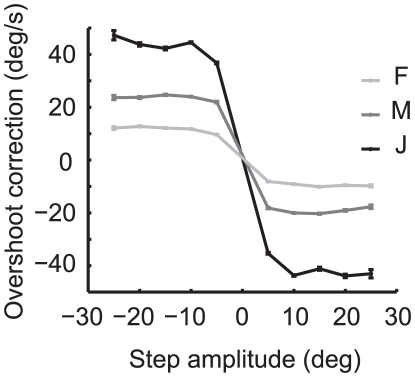
Mean velocity of the overshoot correction by monkey and step size.Error bars represent the standard error of the mean.